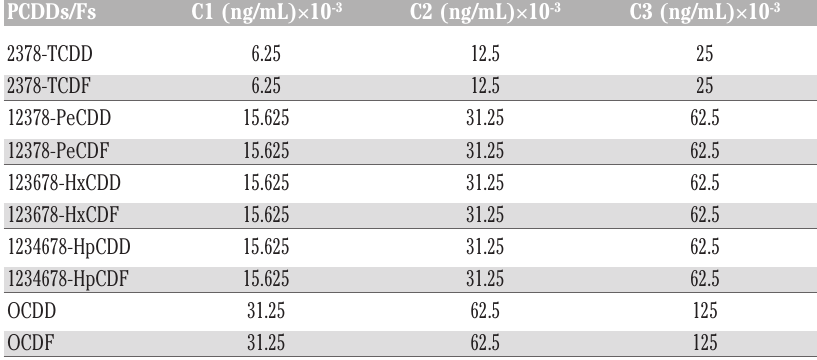
Table 3. Final concentrations of PCDD/Fs in tubes before incubation for 3